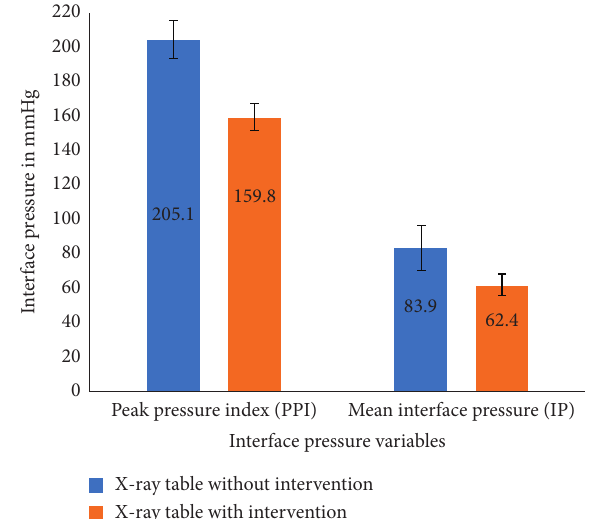
Figure 1: Comparison of mean IP and PPI with standard deviation on the X-ray table with and without the